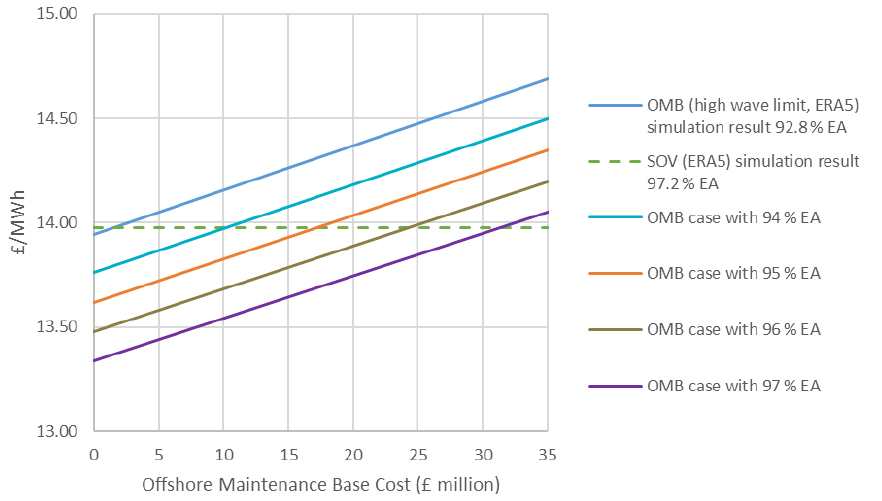
Figure A2. The effect of changing energy availability on the